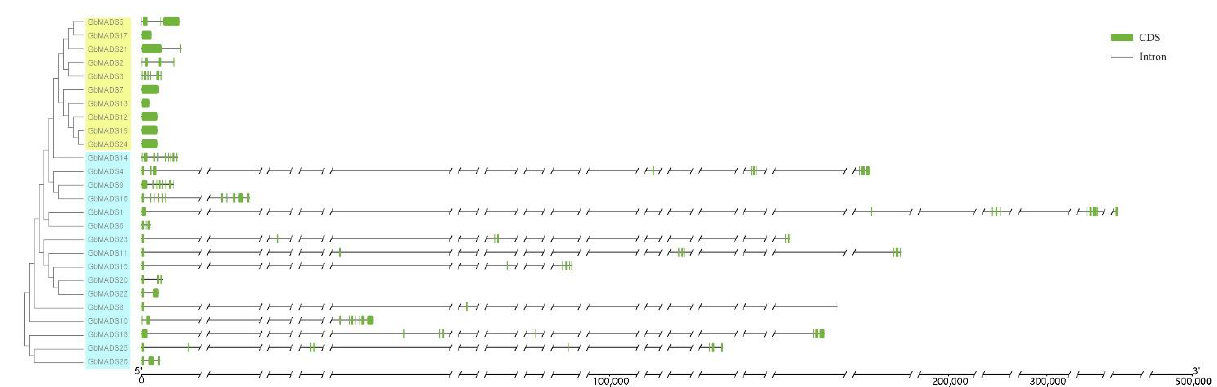
Figure 2. Conserved motif of GbMADS gene family in G. biloba . In the phylogenetic tree constructed based on the full-length sequence of GbMADS proteins, the yellow background color was labeled with type-I GbMADS proteins, and the blue background color was labeled with type-II GbMADS proteins. Boxes of different colors represent 10 putative motifs. The length of protein can be estimated using the scale at the bottom.